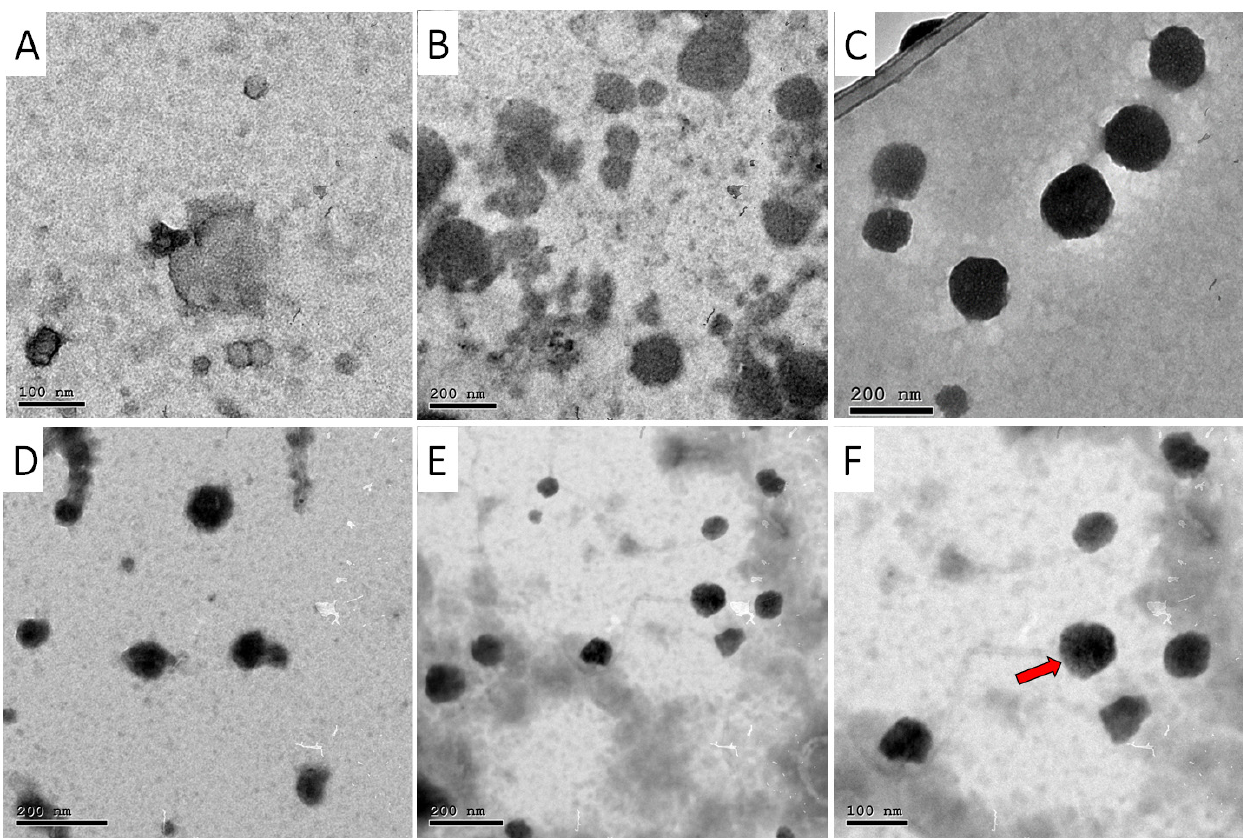
Figure 1. TEM images for ( A ) AA/CS NPs, ( B ) OX/CS NPs, ( C ) AA-OX/CS NPs, ( D ) AA/PEG-CS NPs, ( E ) OX/PEG-CS NPs, and ( F ) AA-OX/PEG-CS NPs. The arrow shows the PEG layer coating the CS NPs.